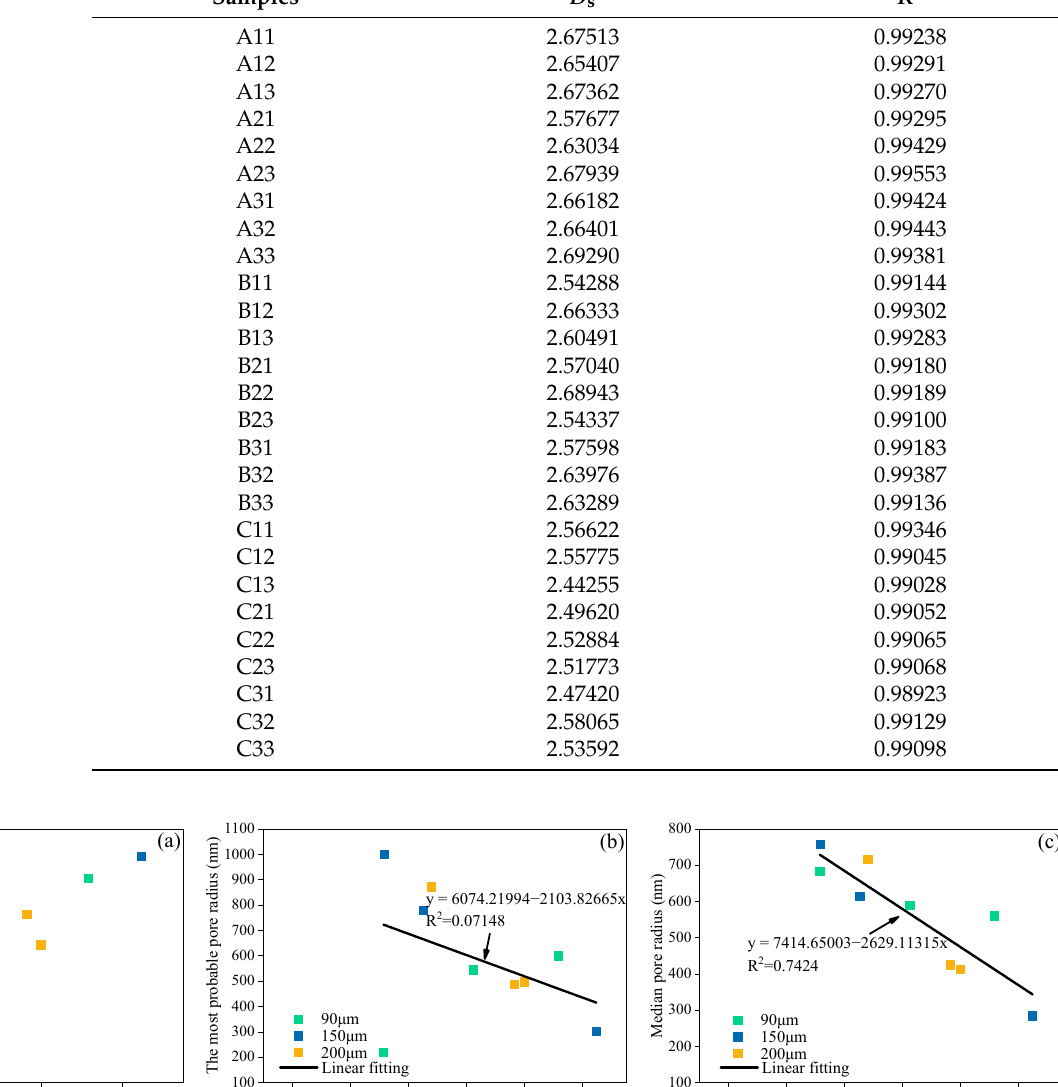
Table 3. Surface fractal dimensions ( D s ) of porous alumina pore surfaces. Samples